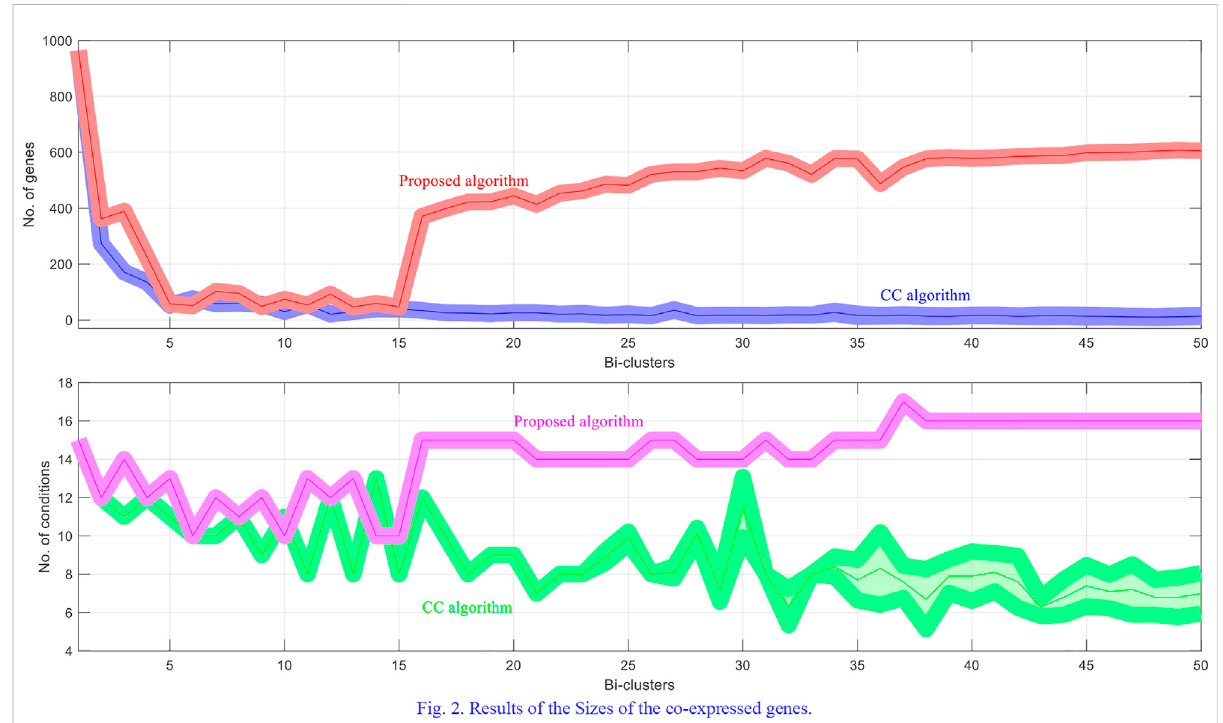
FIGURE 2 Results of the Sizes of the co-expressed genes.